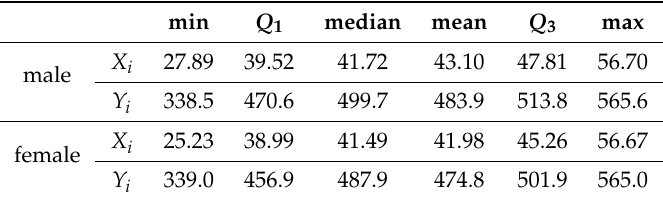
Table 4. Summary statistics of our PISA 2015